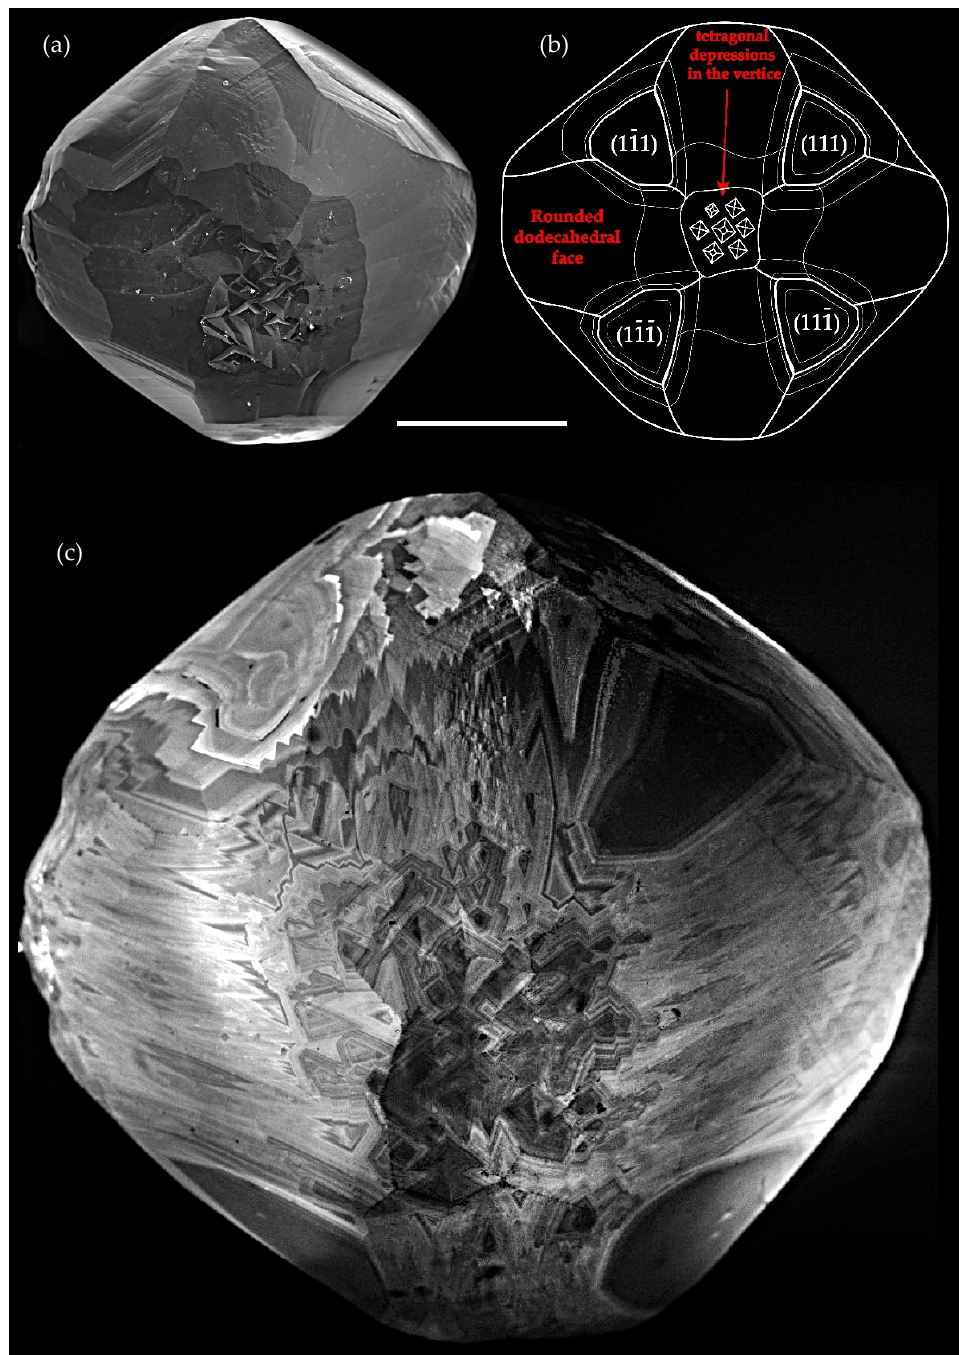
Figure 2. Partly dissolved diamond crystal of rounded octahedral habit with tetragonal depressions in vertices: ( a ) SEI of the surface morphology, the scale bar is 1 mm; ( b ) idealized scheme of crystal faceting; ( c ) enlarged CL image of the crystal with visualization of the regeneration zoning {111}.